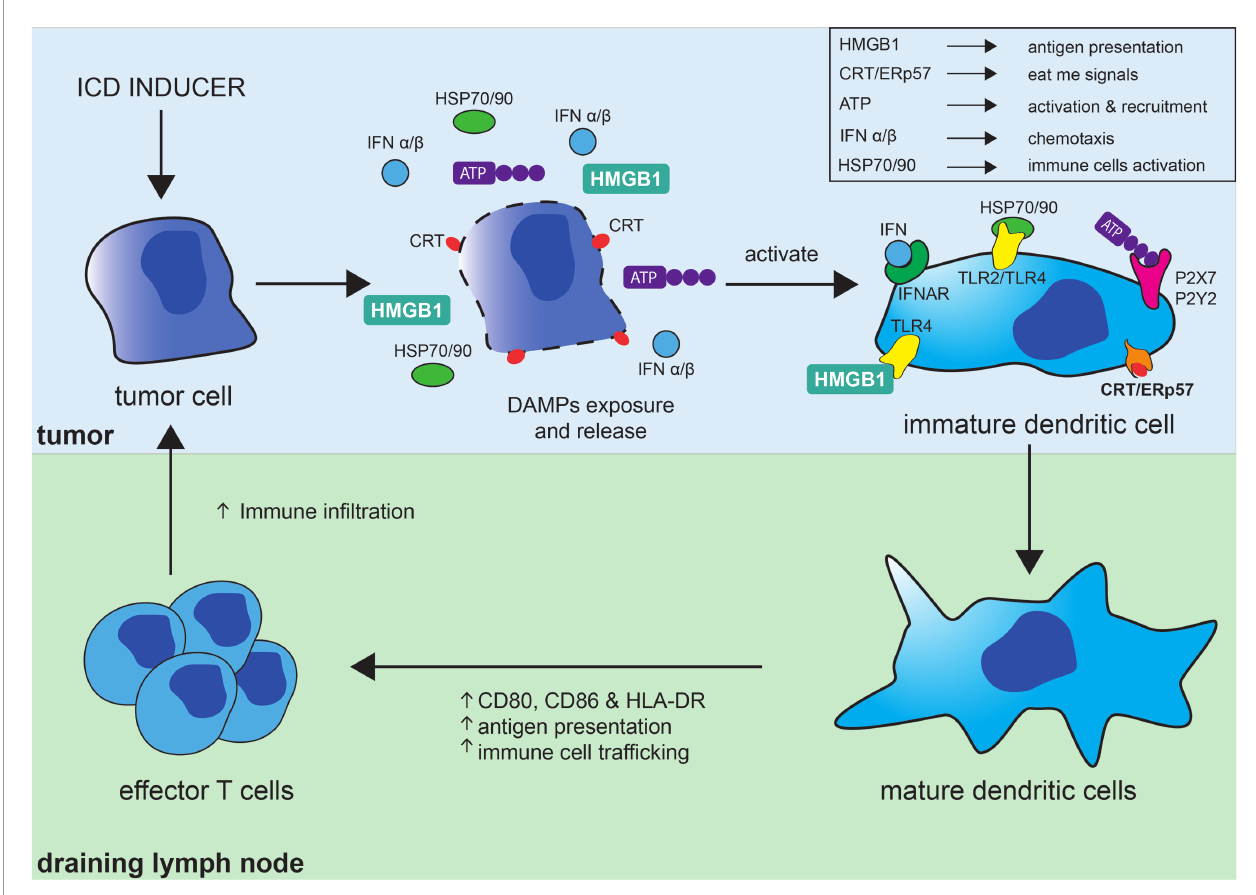
FIGURE 1 | Immunogenic cell death in the tumor context and its consequences on the induction of adaptive immune responses. Immunogenic cell death (ICD) of tumor cell can be induced by different strategies (chemotherapy, oncolytic viruses, radiation therapy, photodynamic therapy, necroptosis, or pyroptosis) and results in the exposure of “ eat me signals, ” like calreticulin (CRT) and ERp57, and release of DAMPs akin to ATP, HMGB1, HSP70, and HSP90. Interaction of CRT/ERp57 with their receptors acts as “ eat me signals ” and facilitate engulfment of tumor cells and tumor antigens, interaction of HMGB1 and HSP70/90 with TLRs increase tumor antigens presentation, and fi xation of ATP on P2X7 and P2Y2 activate and recruit dendritic cells (DC). ICD and subsequent TLRs stimulation is also accompanied by cytokines release notably by a robust type I interferon (IFN a / b ) response, which have broad immune-stimulatory activities. DAMPs and cytokines further participate in the maturation and stimulation of DC leading to increased MHC and co-stimulatory (CD80/CD86) molecules expression, antigen capture and presentation, and their migration to lymph nodes. DC have important implications for the initiation of adaptive immune responses and are involved in the phagocytosis and processing of tumor antigens and their direct and cross-presentation to CD4 + and CD8 + T cells, respectively, contributing to the activation and proliferation of effector anti-tumor T